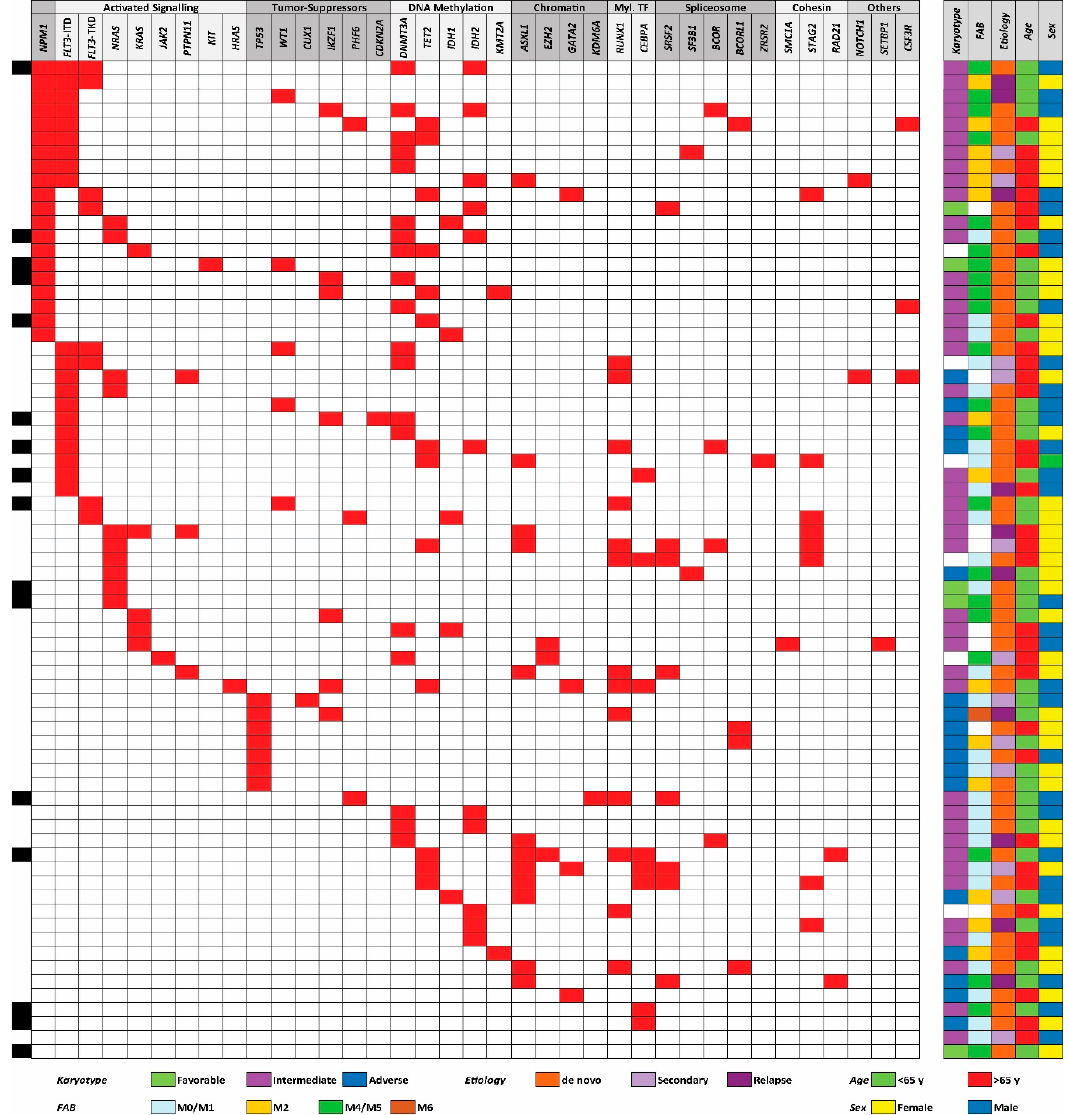
Figure 1. The total genomic profile and organization of mutations into defined categories; an overview of the data for the 71 AML patients included in our study. The figure shows the somatic mutations identified from a 54 gene mutation panel, the mutations being classified as described previously [6,7]. A majority of 69 patients had at least one detectable mutation. Risk classification of the karyotypes, morphological signs of differentiation (i.e., FAB-classification), etiology, age, and gender are presented in the right part of the figure. The patients selected for proteomic analyses are indexed with black in the left part of the figure.